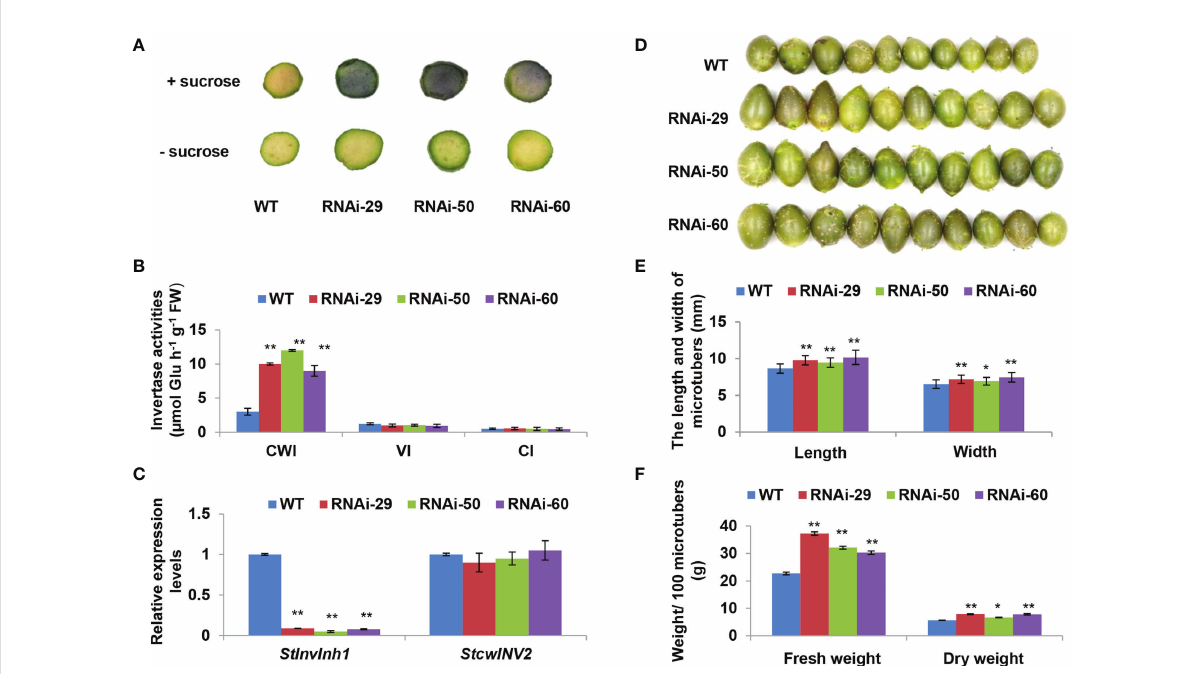
FIGURE 6 Performances of microtuber size and weight in RNAi lines. (A) Histochemical staining of NBT indicating the increased acid invertase activities of two-week-old microtubers in the RNAi lines. (B) The invertase activity determined by enzyme assay in vitro indicating the signi fi cantly increased the CWI activity in the RNAi micro-tubers without impacting the activities of VI and NI. (C) RT-qPCR analysis revealed that StInvInh1 was suppressed in the RNAi micro-tubers without impact on mRNA levels of StcwINV2 . (D) Performance of micro-tuber size in RNAi lines (10 four-week-old microtubers are shown in each line). (E) The length and width of micro-tubers in RNAi lines. (F) The fresh and dry weight of microtubers in RNAi lines. The relative expression levels of StInvInh1 and StcwINV2 are presented in relation to the expression levels of ef1 a (AB061263) transcripts (100). The relative expression level of each gene and each enzyme activity in transgenic lines was compared with that in wild-type control E3. Each value was the mean ± SD of three biological replicates. Signi fi cant differences in values (**P < 0.01, *P < 0.05) by Student ’ s